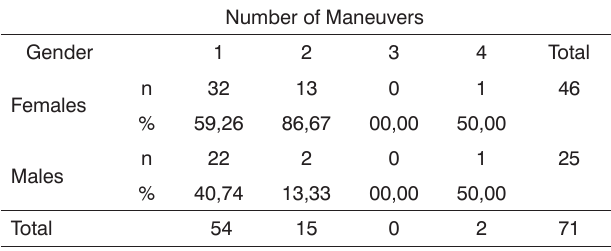
Table 1. Crossing the number of maneuvers and gender